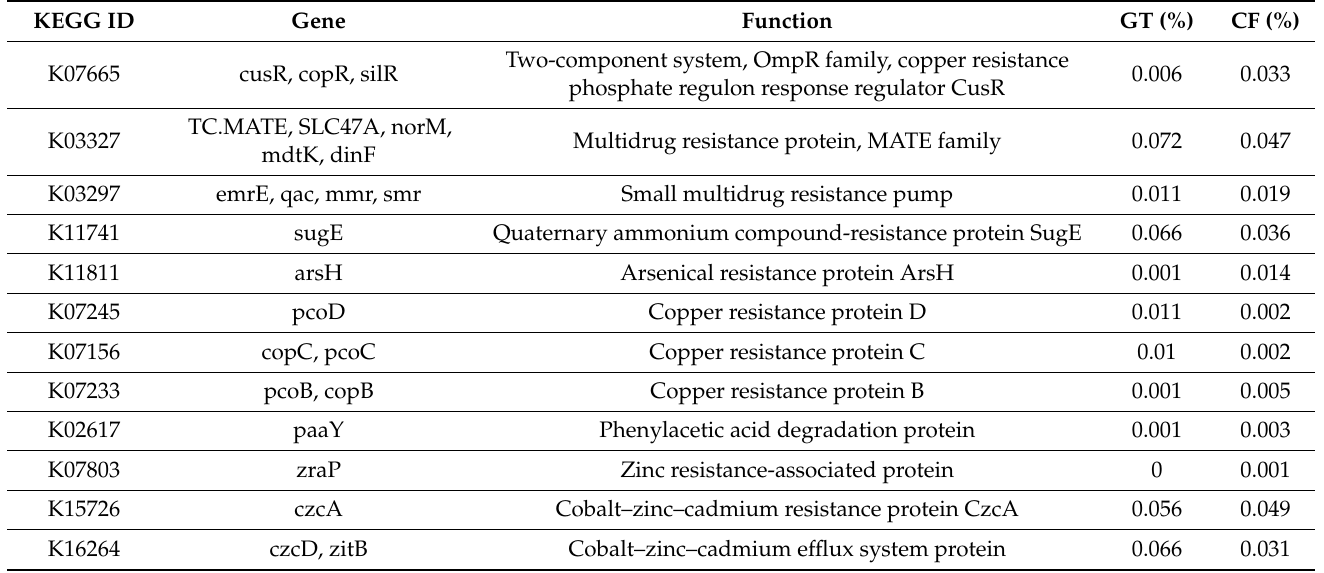
Table 2. List of the KEGG gene categories related to resistance to antibiotics, toxic metals, and toxic compounds found in our study and in C. ramosus larval microbiome in Sele et al.’s study (2021). GT: G. tokunagai ; CF: C. flaviplumus